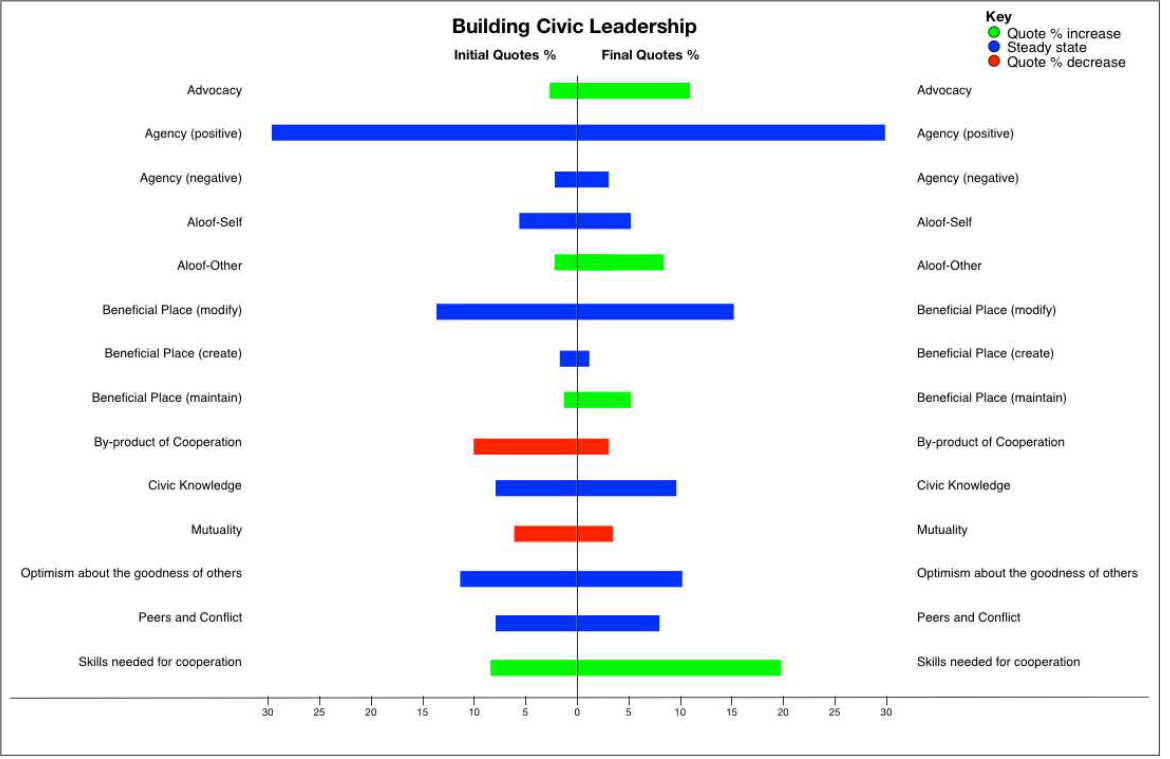
Depiction of initial and final focus group quote